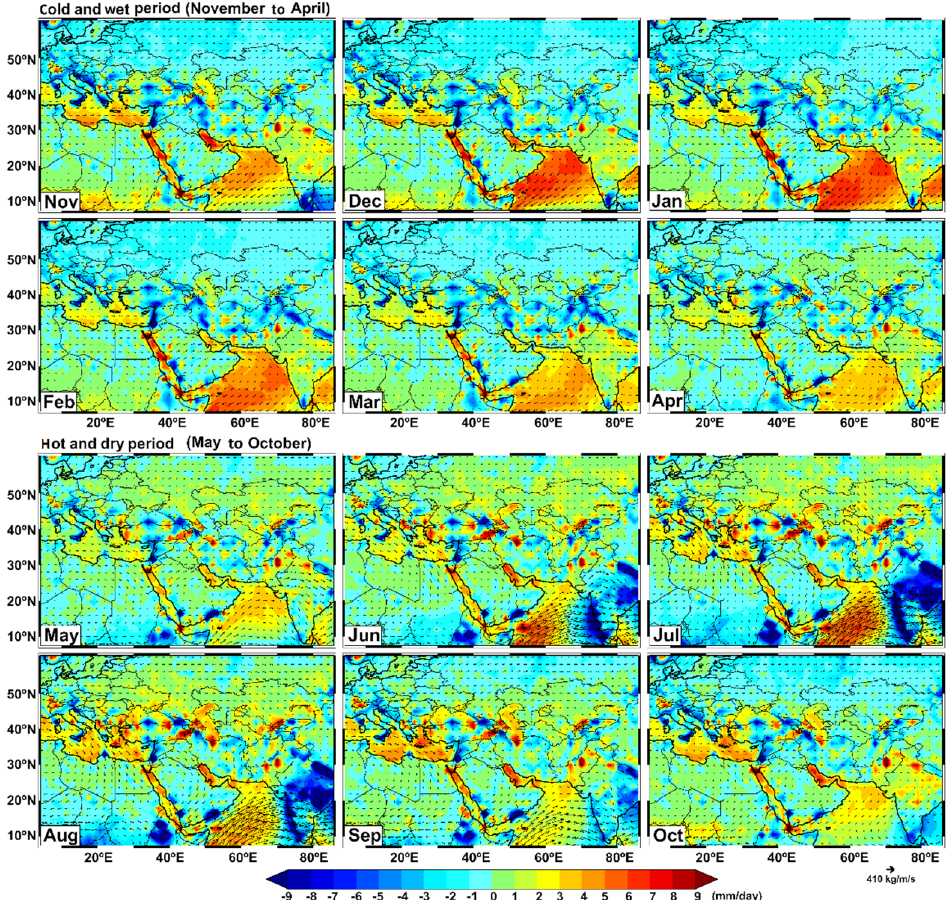
Figure 2. The northward and eastward vertically integrated moisture flux (VIMF) data obtained from the ERA-Interim Reanalysis with a resolution of 1° × 1° for the period of 1981 to 2015 [40].